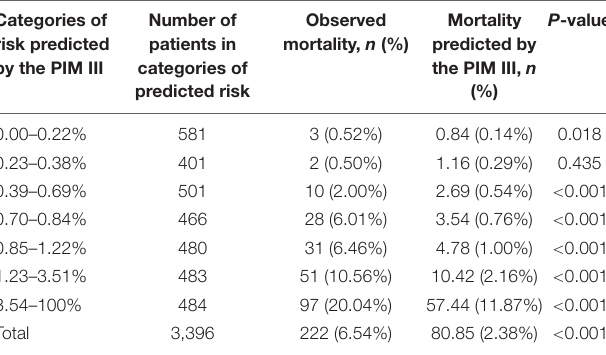
TABLE 4 | Mortality observed and predicted per category of predicted risk for the Pediatric Index of Mortality III*.